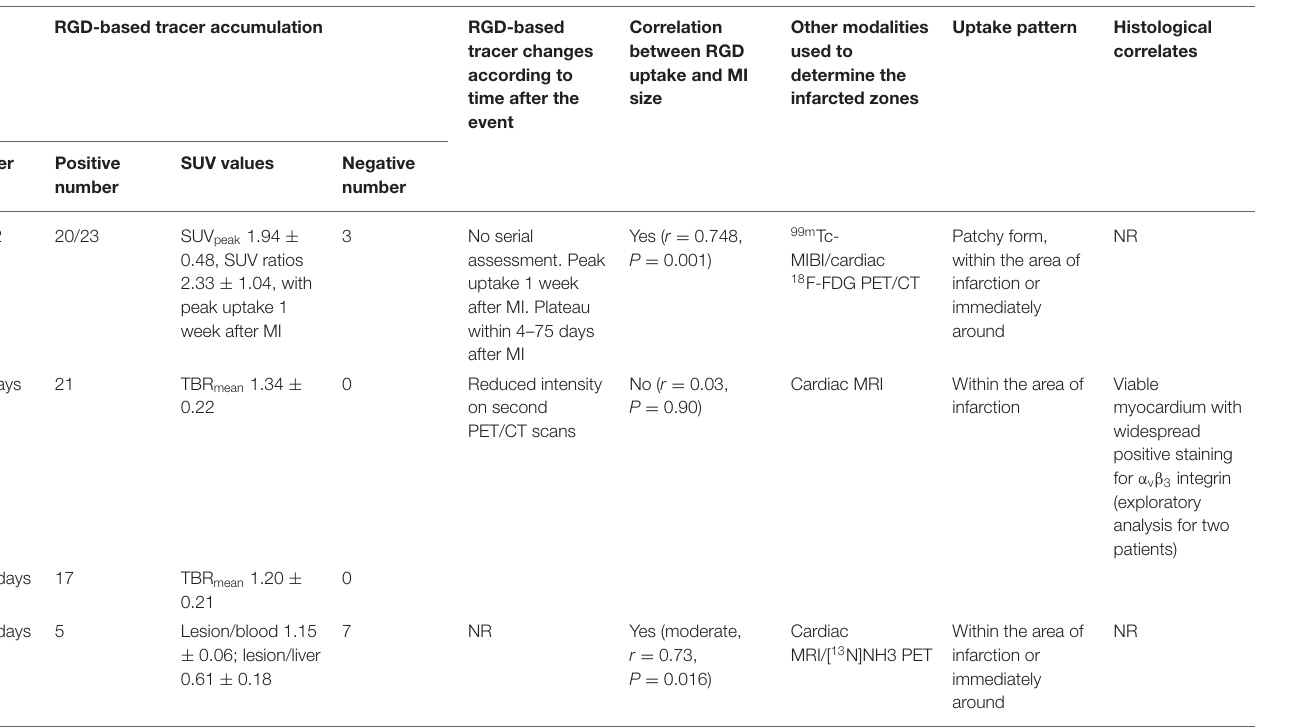
TABLE 3 | Summary of PET findings for studies focused on the infarcted